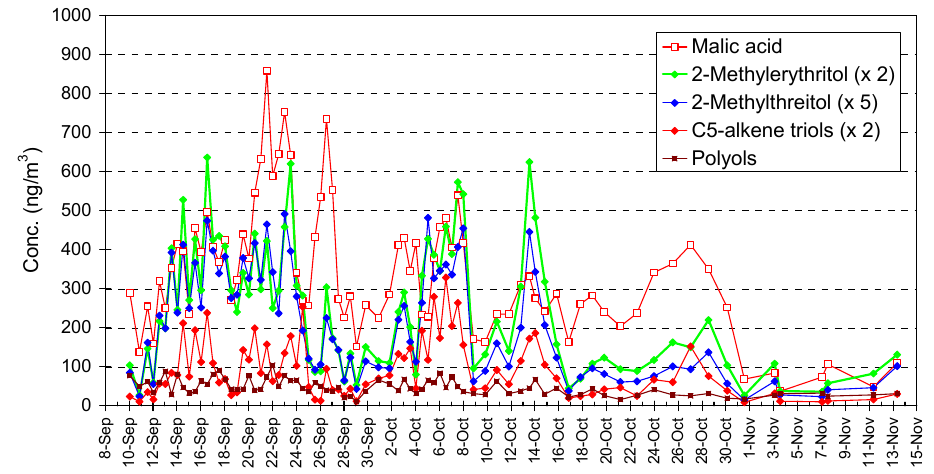
Fig. 5. Time series for malic acid, 2-methyltetrols (2-methylthreitol and 2-methylerythritol), C 5 -alkene triol derivatives of isoprene (sum of 2-methyl-1,3,4-trihydroxy-1-butene ( cis and trans ) and 3-methyl-2,3,4-trihydroxy-1-butene) and polyols (sum of arabitol, mannitol, and erythritol) in the fine filters of the HVDS samples.